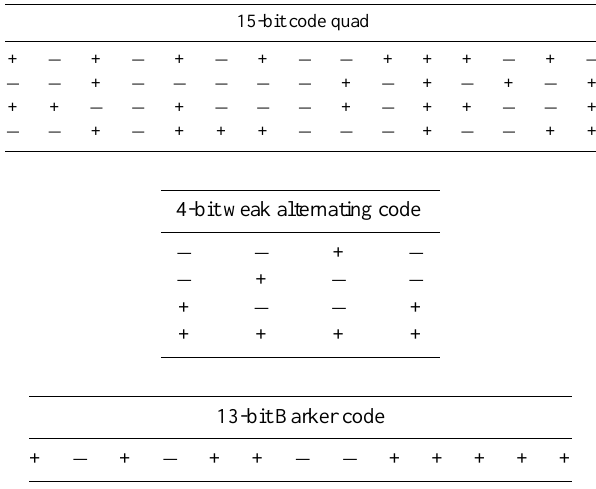
Table 1. Phase codes used in the